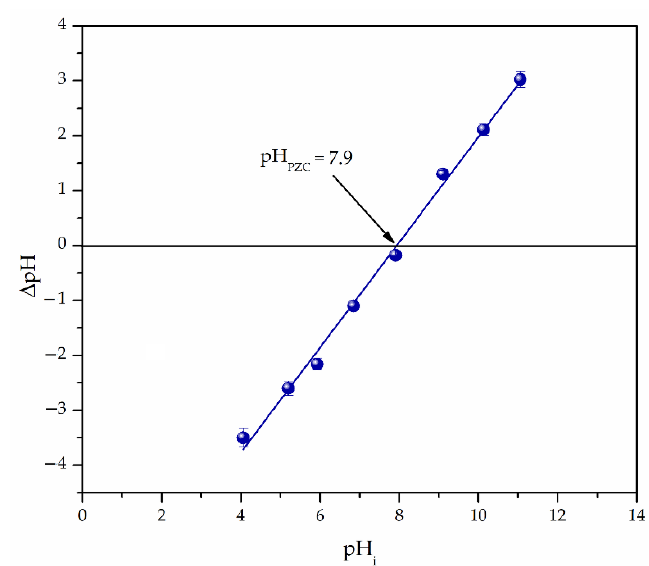
Figure 5. Point of zero charge (pHpzc) for Fe 3 O 4 @APTMS/PGME-deta. Standard errors are shown as vertical error bars.